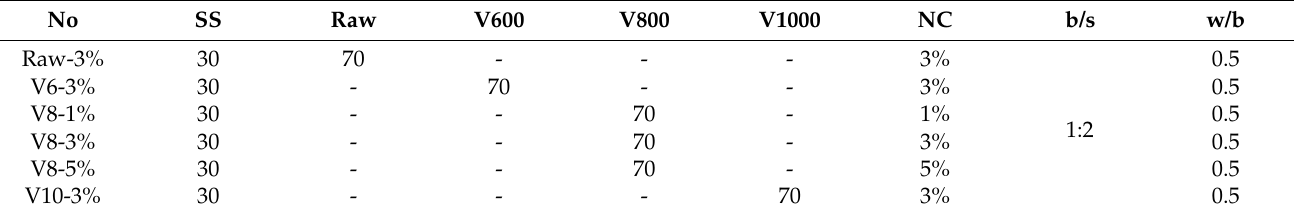
Table 2. The mixture proportions of specimens (wt %).